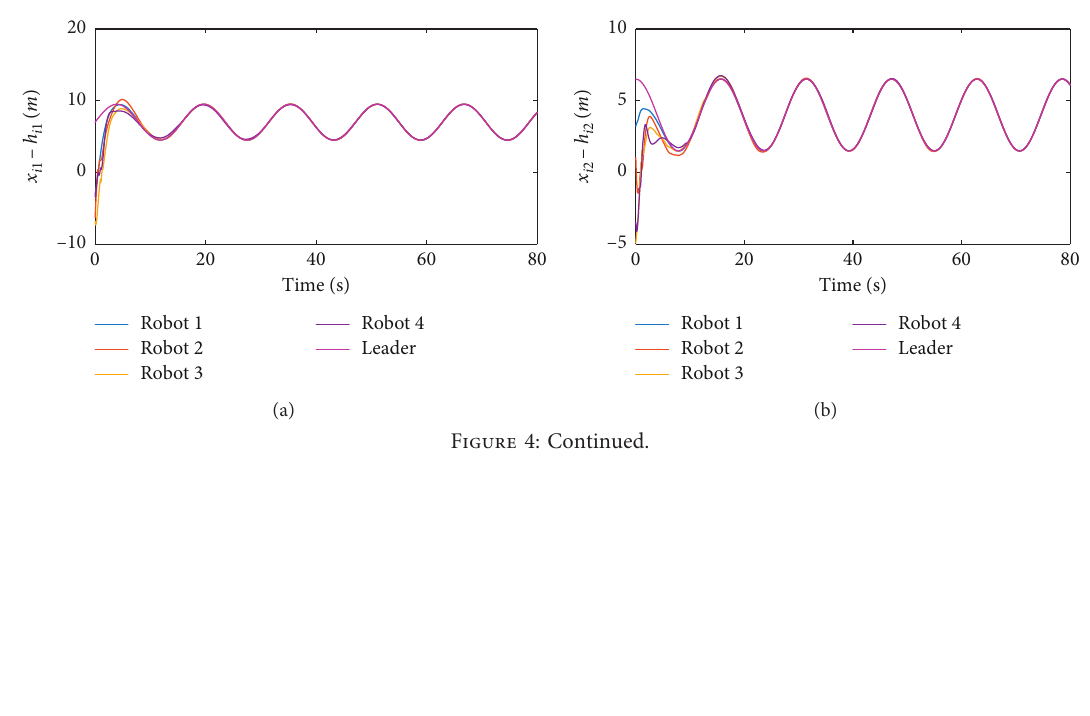
􏽥 x i 2 (d) in Example 1.